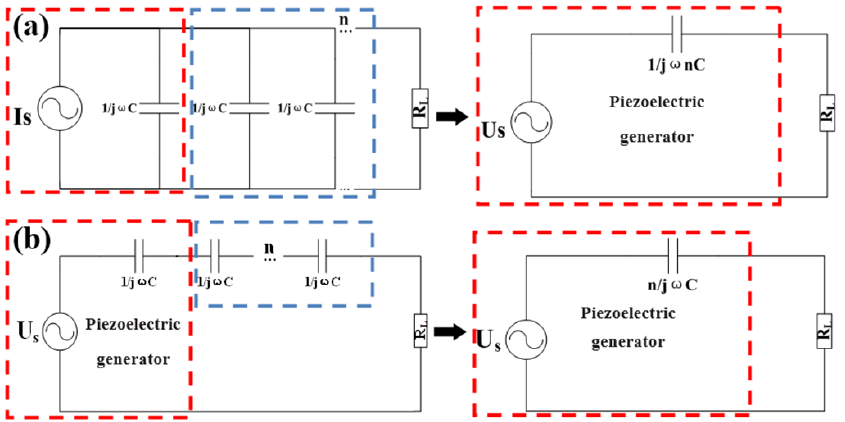
Figure 2. Equivalent circuit of an arrays of beams vibration energy harvester (AB-VEH) system ( a ) in parallel and ( b ) in series.